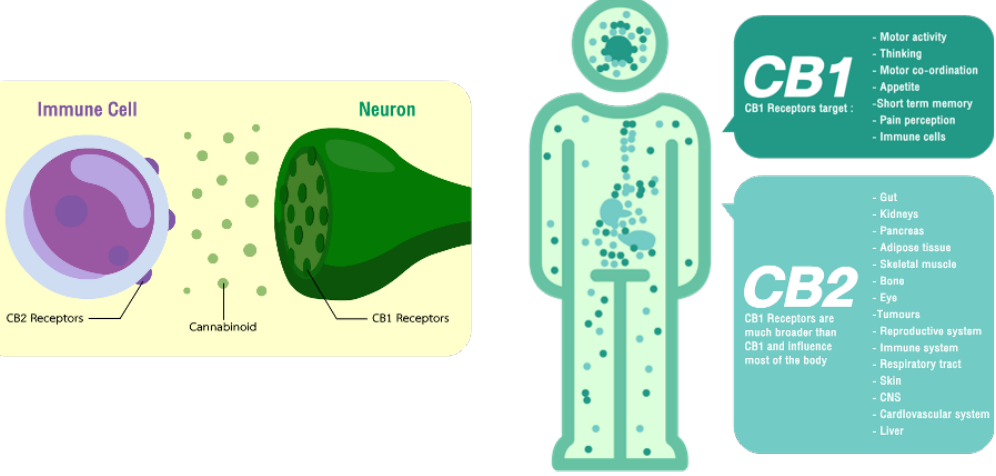
Figure 1. Localisation of the cannabinoid receptors and their therapeutic